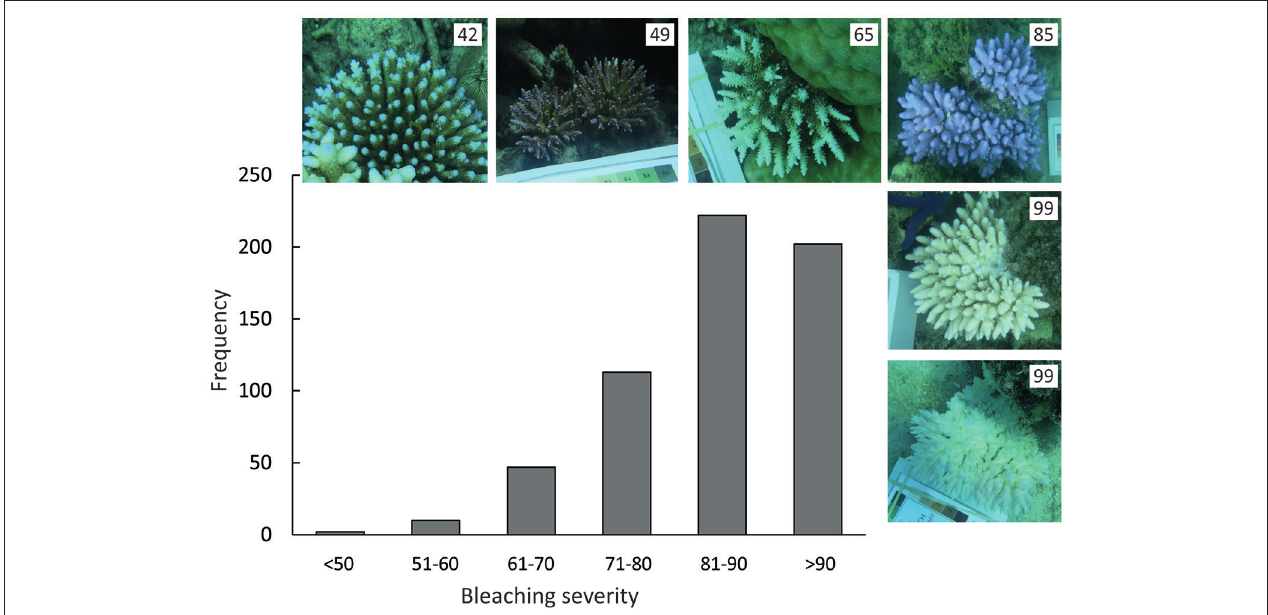
FIGURE 1 | Frequency distribution of bleaching severity measurements for Acropora corals ( N = 596) at Lizard Island in March 2016, as measured from white-balanced images of corals in situ . Photos show representatives of coral colonies with different bleaching severity, and numbers in the upper right hand corner of each image show the bleaching severity for each coral.